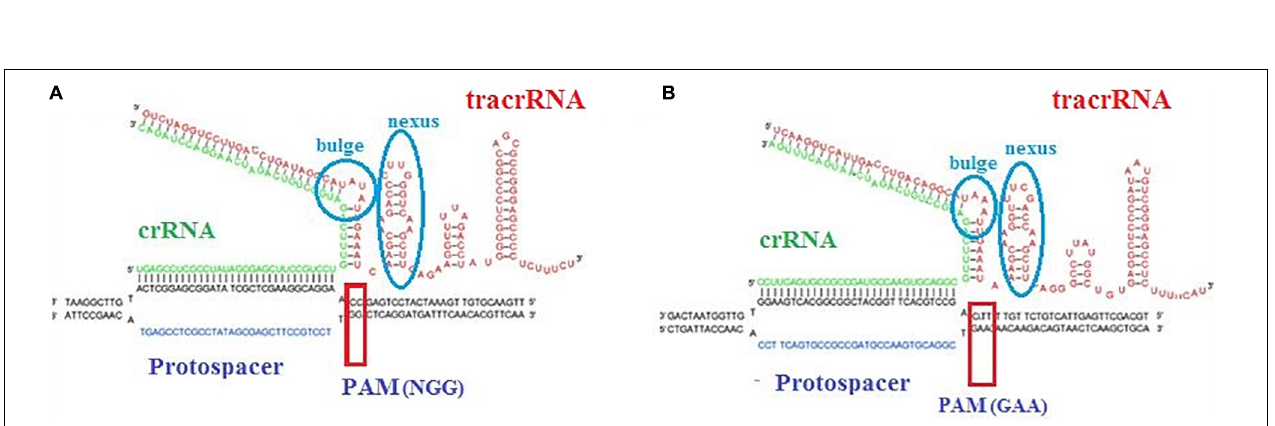
FIGURE 3 | Representative crRNA:tracrRNA duplex binds with target DNA sequence next to PAM sequence in CRISPR-Cas subtype II-A (A) and subtype II-C (B) .